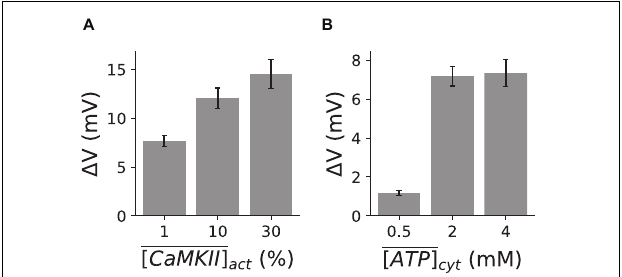
FIGURE 4 | Effect of CaMKII activation and ATP depletion on the genesis of DADs.The mean and standard deviation of the DAD amplitude under three clamped CaMKII activation (A) and ATP (B) levels, respectively. α mPTP = 30. Ten random trials were performed for each clamped CaMKII activation or ATP